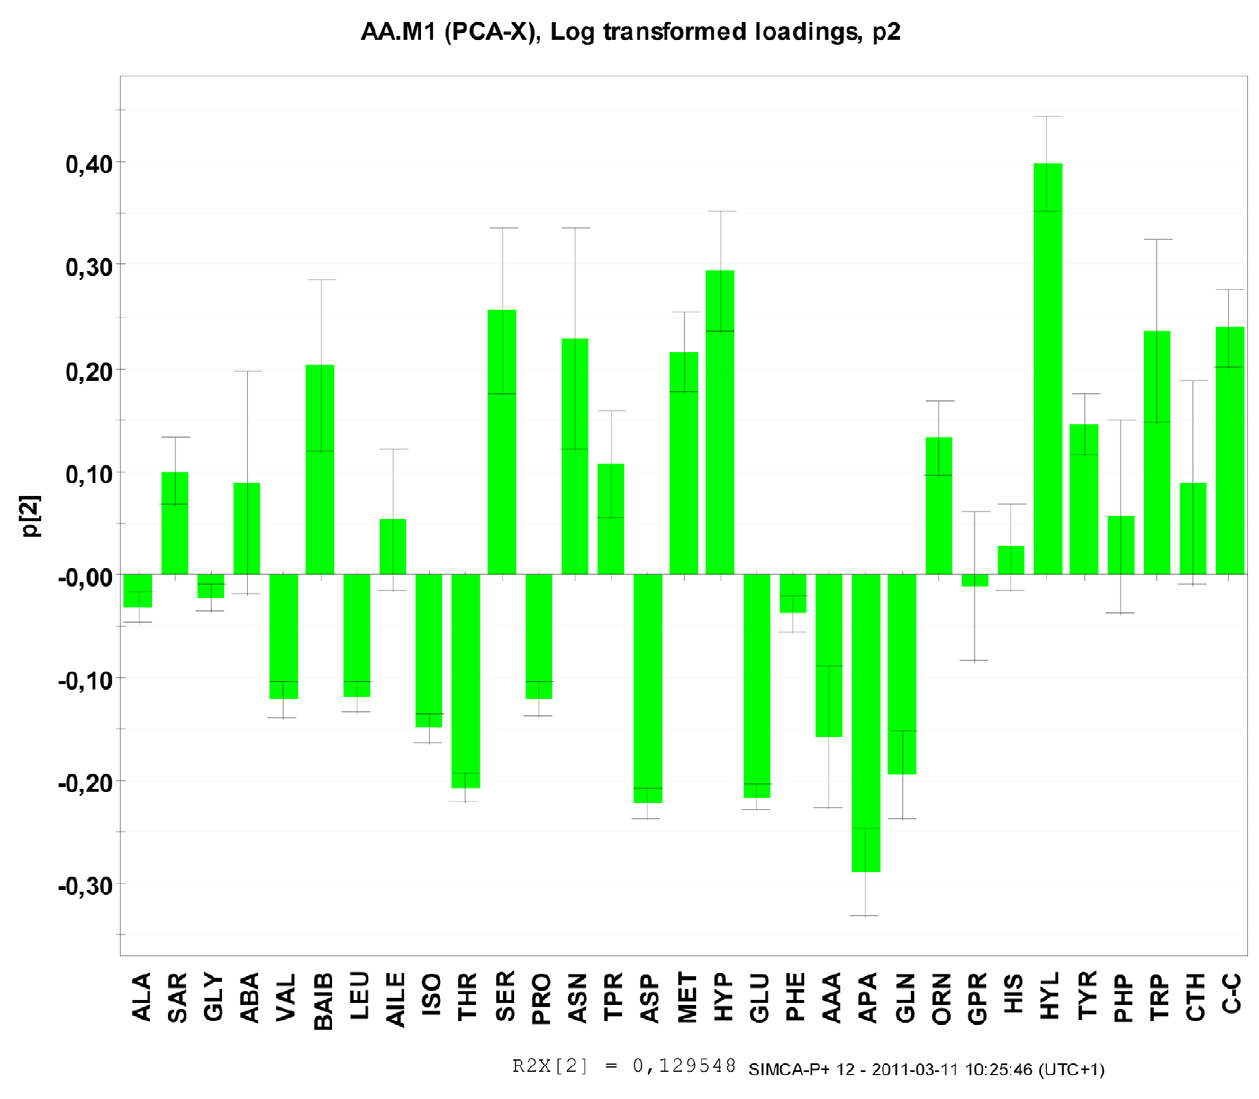
Figure 6. The p2 scores for amino acids from the cell wall extracts of S.epidermidis and S.lugdunensis following prolonged exposure at 4 6 C for 8 weeks compared with corresponding cultures grown under ideal conditions at 37 6 C representing the reference control samples. S. epidermidis and S. lugdunensis responded to the cold stress by substantially altering amino acid profiles relative to the respective controls. It should be emphasized that the PC2 were inversely correlated to cold treatment such that negative loadings, e.g. - 0,20 for GLN, indicated increased amino acid levels in the cold treated S. epidermidis and S. lugdunensis samples, and vice versa.